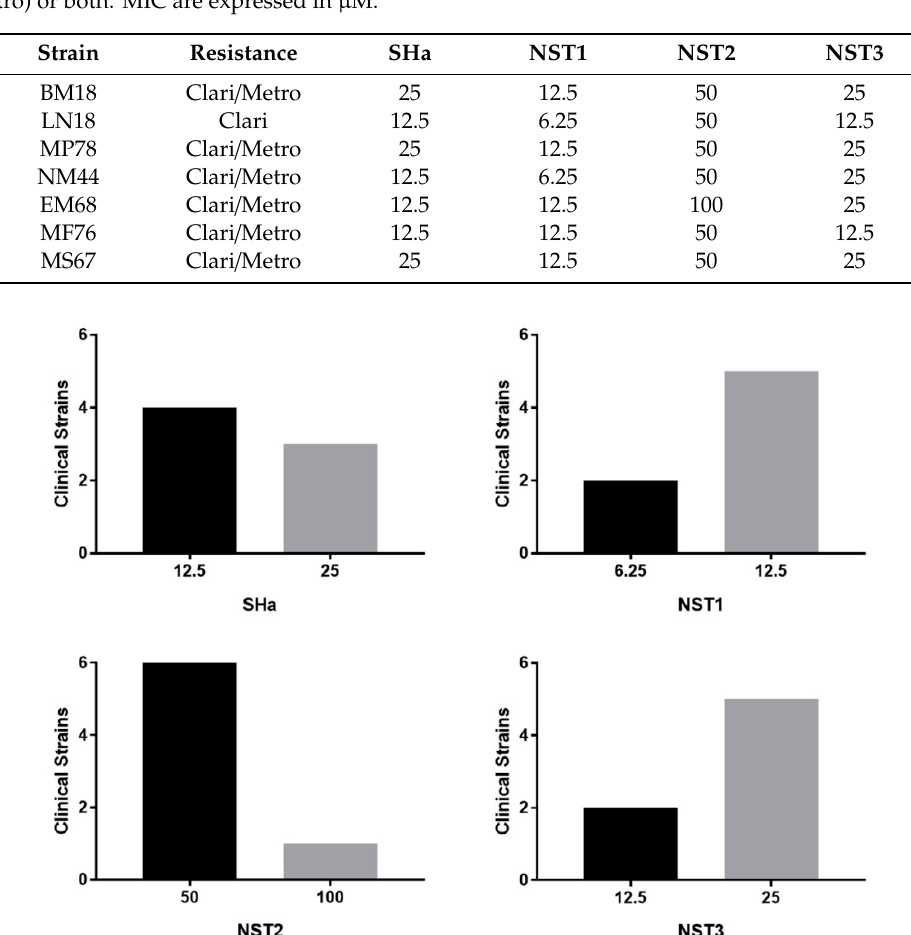
Table 5. Antibacterial activity of temporin SHa, NST1, NST2, and NST3 against resistant clinical strains of H. pylori . Clinical strains were found resistant either to clarithromycin (Clari) or metronidazole (Metro) or both. MIC are expressed in µ M.